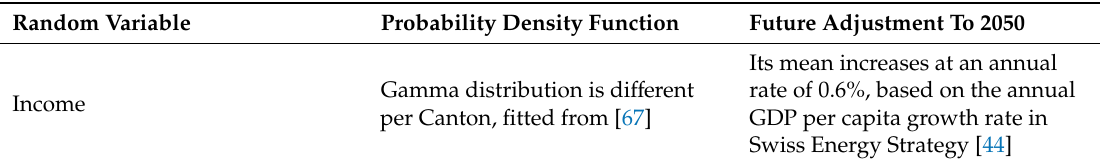
Table A4. One-dimensional probability density functions used in the model, together with their data sources and method of future